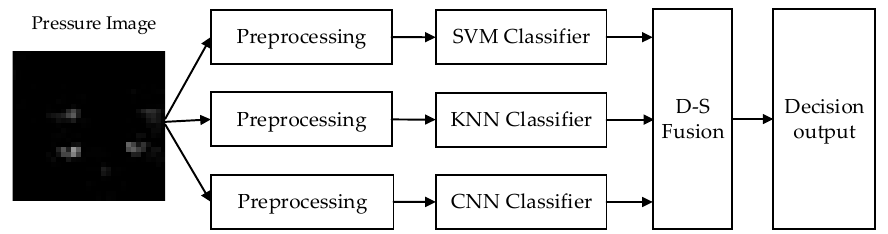
Figure 5. Framework of the multi-classifier (CNN classifier, support vector machine (SVM) classifier, k -nearest neighbor (KNN) classifier, and the Dempster–Shafer (D–S) evidence theory) fusion algorithm (CSK–DS).